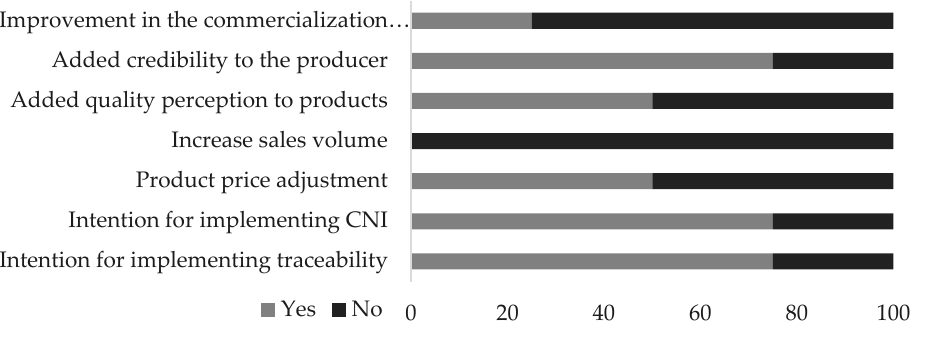
Figure 3. Traceability criteria implementation and farmers perception. χ 2 = 16.0; p = 0.0137; CNI = Brazilian traceability law.